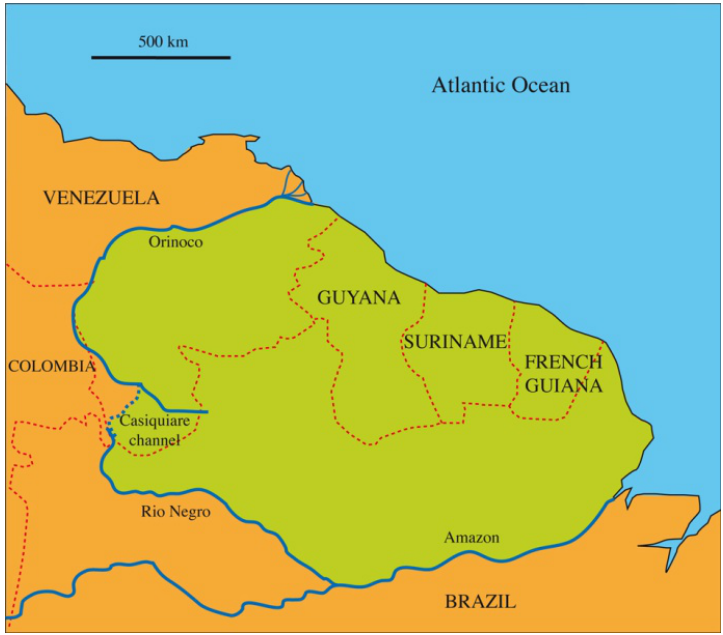
Figure 1. Map of the